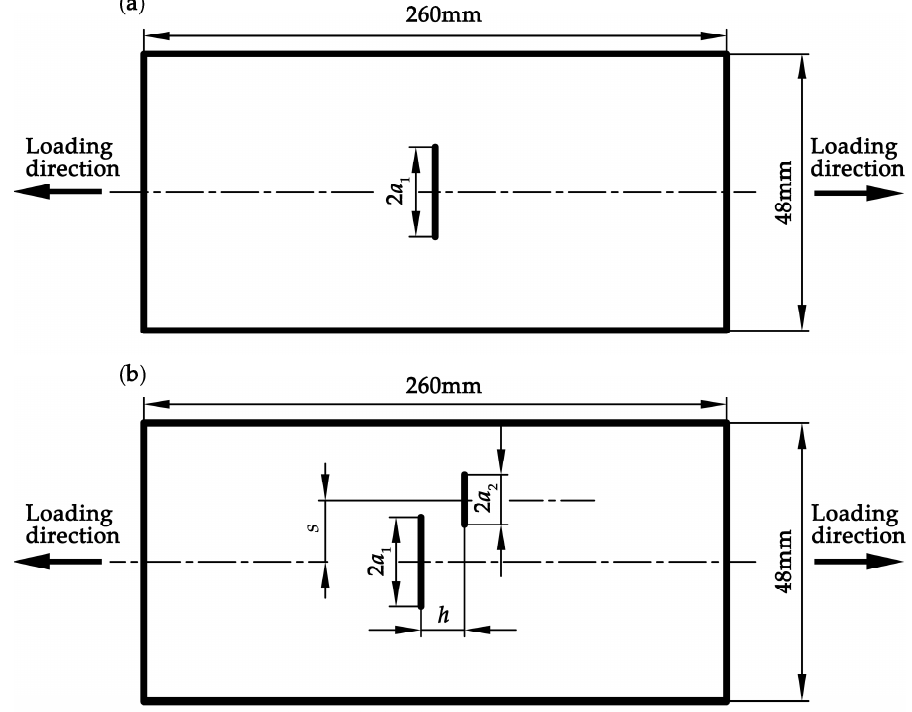
Figure 8. Geometryofthetestspecimens: ( a )thesinglecrackspecimen; and( b )theparallelcrackspecimen. Figure 8. Geometry of the test specimens: ( a ) the single crack specimen; and ( b ) the parallel crack specimen.